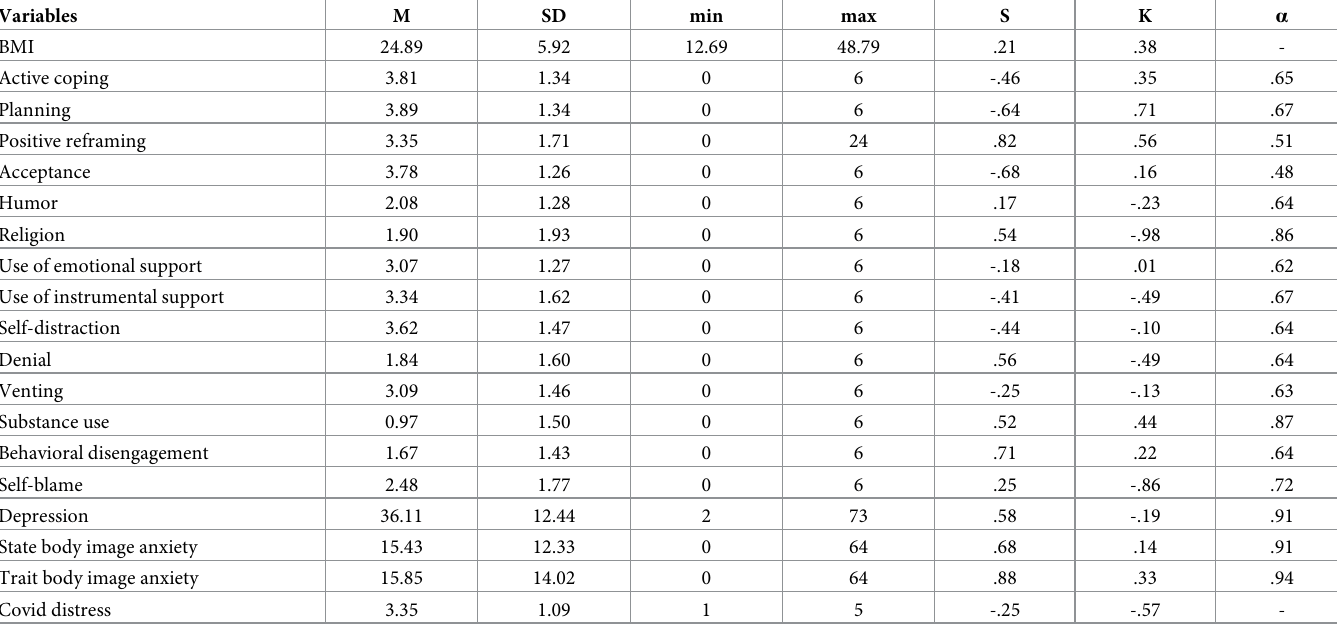
Table 2. Descriptive statistics for analyzed variables.